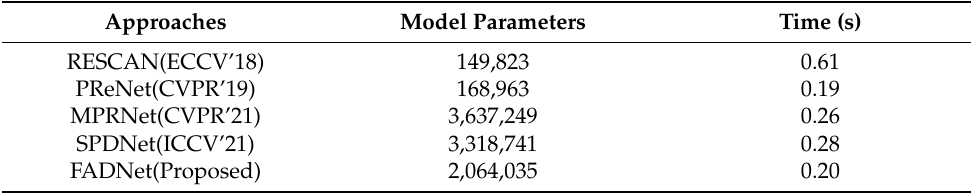
Table 5. Comparison on model parameters and processing time per